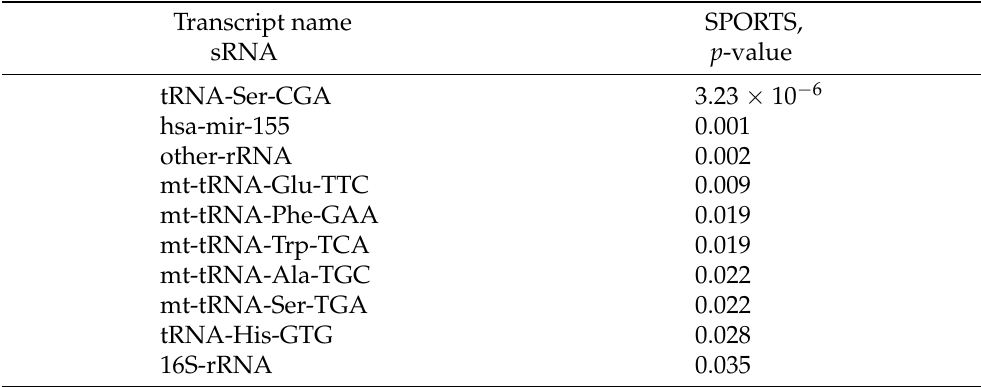
Table 7. Top 10 differentially expressed small RNA (sRNA) transcripts and tRNA-derived small RNA (tsRNA) with adjusted p -value < 0.1 for Donkin et al. case study processed with SPORTS pipeline with default annotation vs. genome alignment (bowtie + Rsubread/Kallisto) pipeline based on